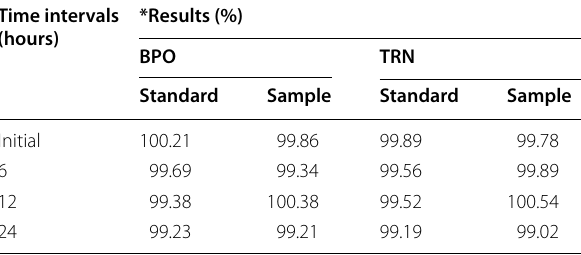
Table 2 Solution stability